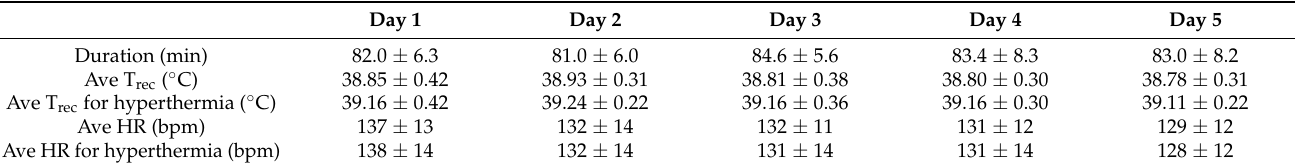
Average HR, T rec , and TS were significantly lower at post-HA (HR, 134 ± 11